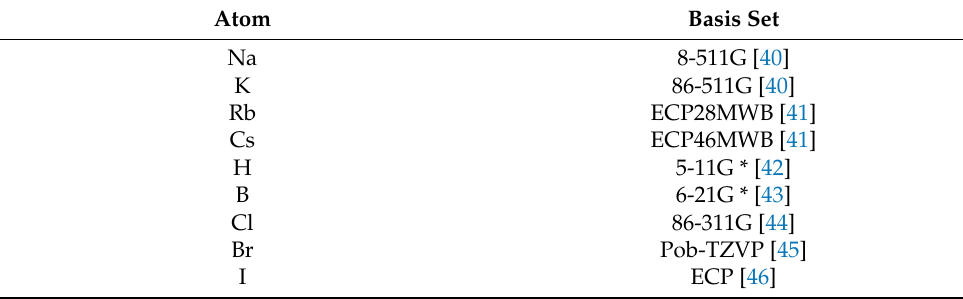
Table 1. Atomic basis sets used in the CRYSTAL calculations.